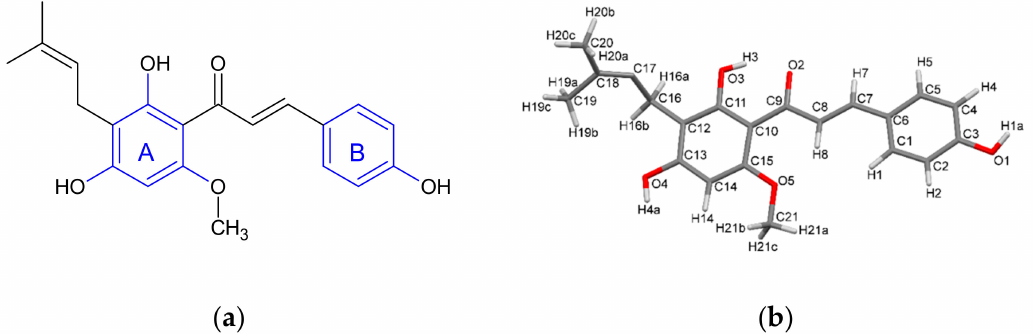
Figure 1. ( a ) Scheme of xanthohumol (XN) structure; ( b ) atom numbering in the XN cocrystals. For more than one XN molecule in the asymmetric part of a unit cell, the su ffi xes A, B, C, and D were added, see crystallographic information files (CIFs) in the Supplementary